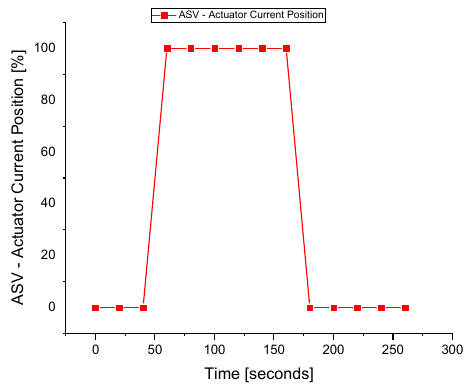
Figure 12. The actuator response during a fault in the P s sensor.